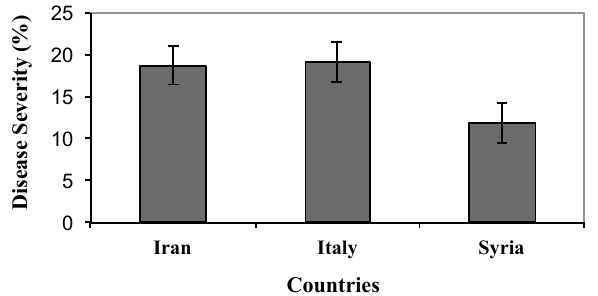
Figure 3. Mean disease severity of eight Iranian, 15 Italian and 11 Syrian Fusarium culmorum strains on durum wheat cv. Normanno in a greenhouse assay, 21 d after inocula- tion. Bars represent the standard errors of